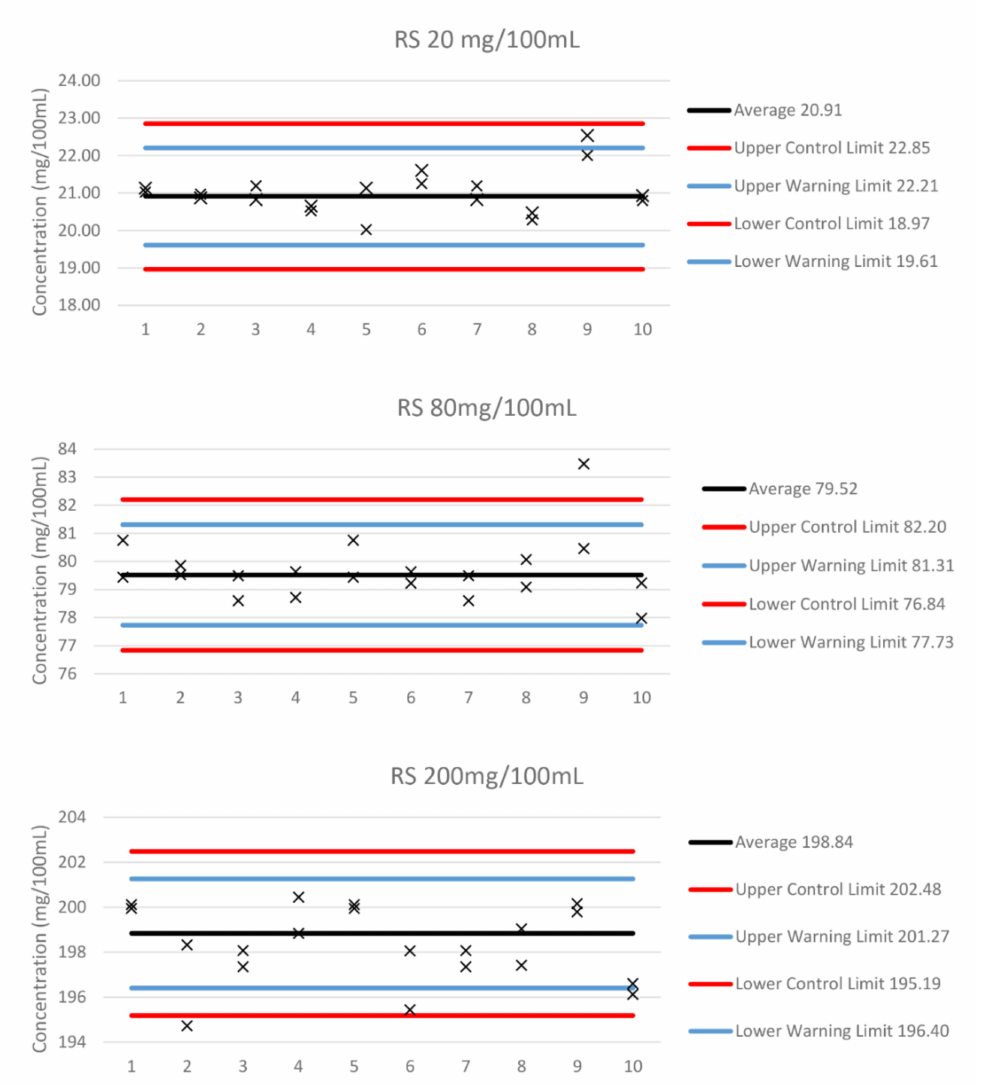
Figure 2. Determination of method uncertainty using the certified reference material : The method has a standard uncertainty at 200 mg/100 mL of 0.65%, at 80 mg/100 mL of 1.2%, and at 20 mg/100 mL of 1.77%, giving expanded uncertainties of 1.95% (or 3.88 mg/100 mL), 3.64% (or 2.89 mg/100 mL), and 5.31% (or 1.11 mg/100 mL), respectively, at a 99.73%